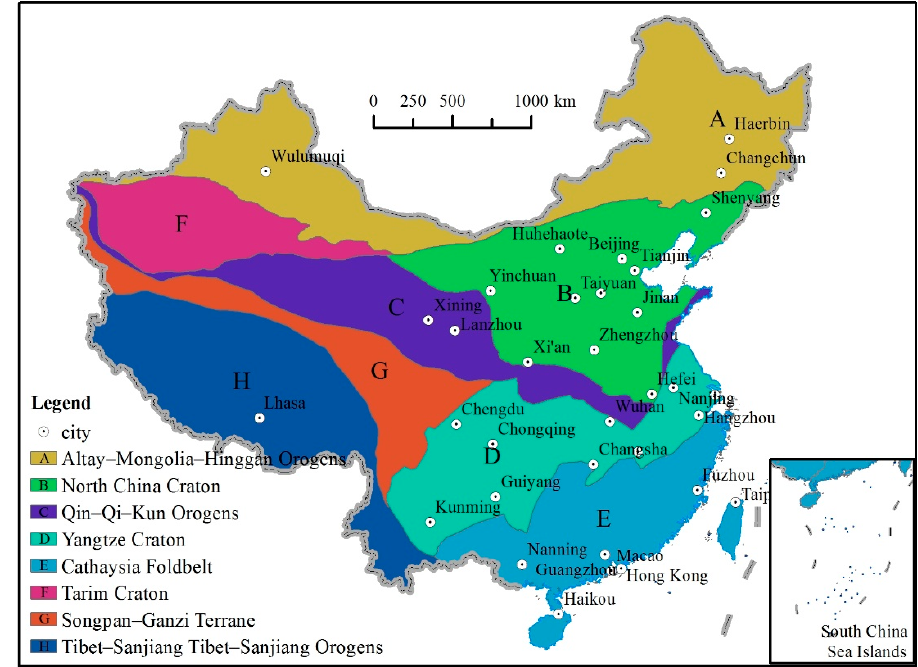
Figure 7. Distribution map of first-order tectonic units in China (redraw from Ren et al. [22]).